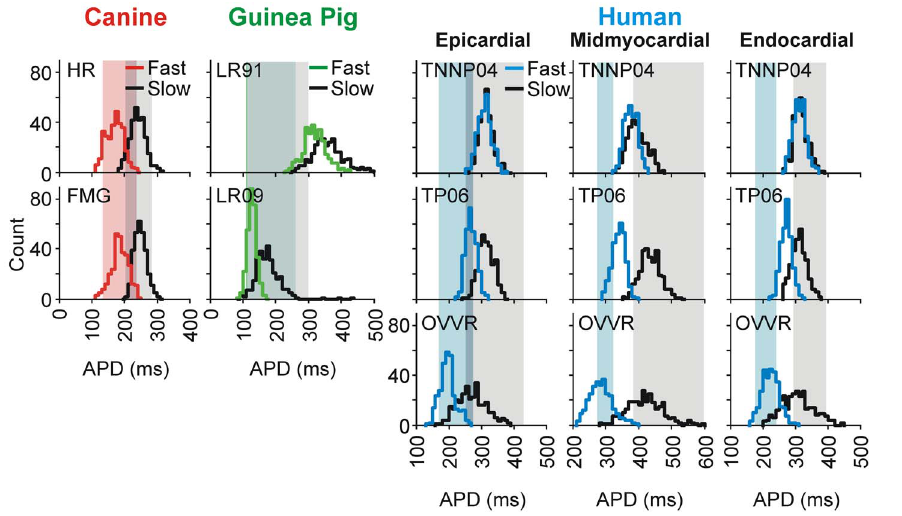
Figure 2. Rate dependence action potential duration across a population of models. APD distributions for models paced at 2 Hz (colored histograms) and 0.2 Hz (black histograms). Shaded regions represent experimental ranges estimated from the following sources: canine [11,55], guinea pig [12,56–57], and human [20,58–61]. Colored shading indicates the range at 2 Hz, gray shading the range at 0.2 Hz, and an intermediate color the range overlap.